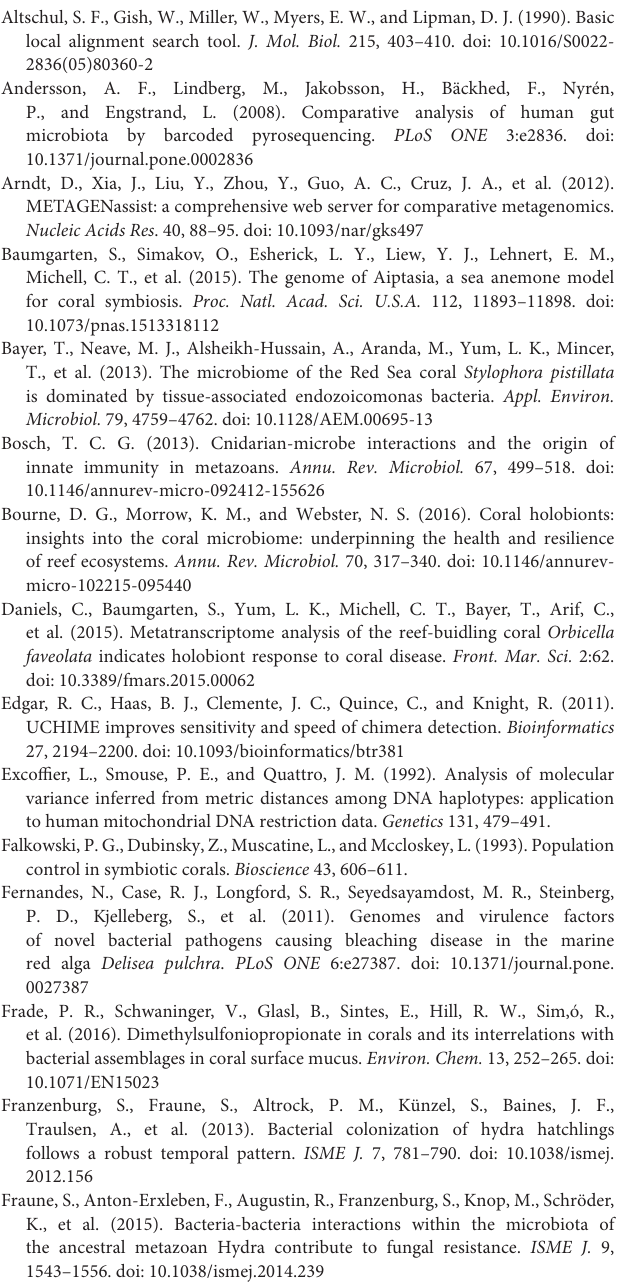
aposymbiotic and symbiotic Aiptasia . Heatmap displaying putative functional differences based on the bacterial community composition of aposymbiotic and symbiotic Aiptasia . Changes are displayed on a relative scale with enrichment in red and depletion in blue. Sym, symbiotic Aiptasia , Apo, aposymbiotic Aiptasia . Supplementary Data Sheet 5 | Conceptual model of cnidarian holobiont functioning and differences between aposymbiotic and symbiotic states (model extended from Rohwer et al., 2002). Functions proposed in the original conceptual holobiont model are in black, putative functions related to the presence of Symbiodinium in green, functions enriched in aposymbiotic Aiptasia in red, and functions present in the aposymbiotic and symbiotic state in